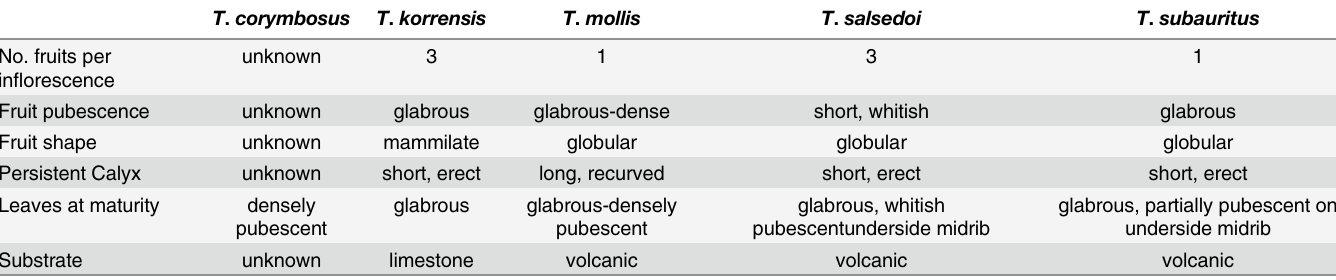
Table 2. Summary of important morphological characters that distinguish the Palau Timonius